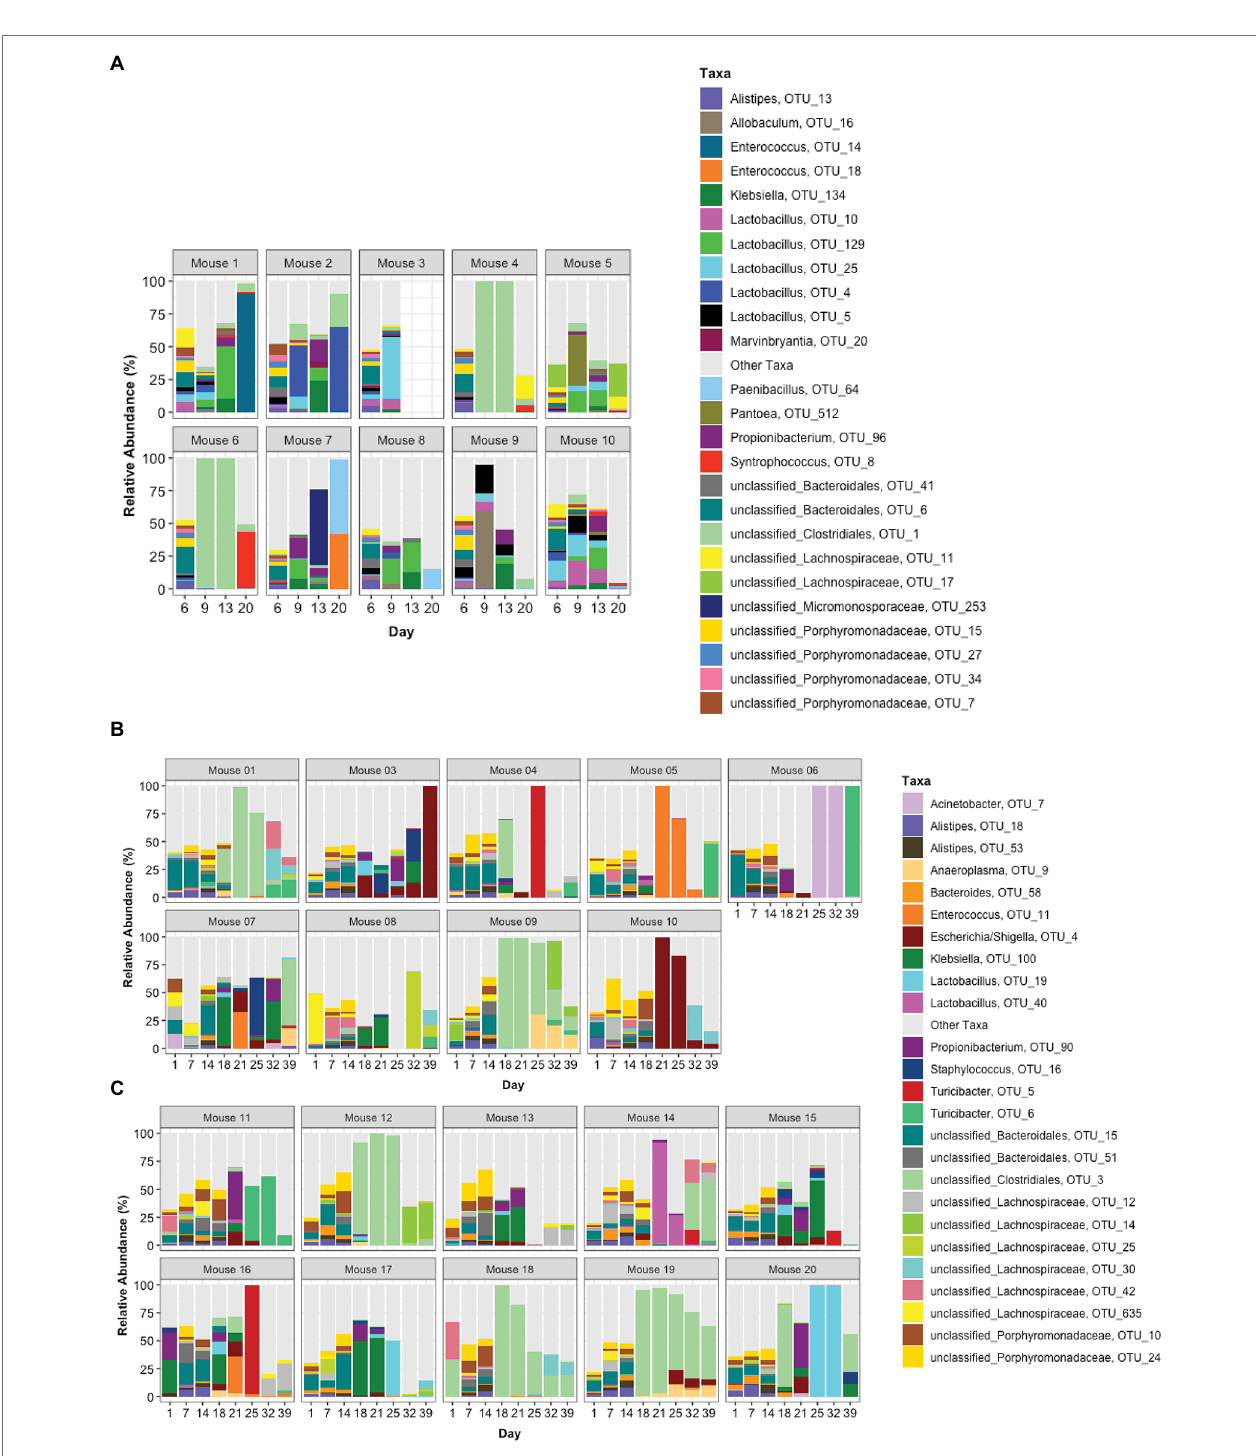
FIGURE 5 | Taxonomic profiles. The relative abundance of taxa is represented by stacked bars for each mouse and each day. The top 25 OTUs are colored individually and all other OTUs are assigned to the “Other Taxa” group (light gray). (A) Portrays TZP1 in which TZP was administered days 7–13, (B,C) portray immunocompetent mice (mice 1–10) and neutropenic mice (mice 11–20), respectively, from TZP2 in which TZP was administered on days